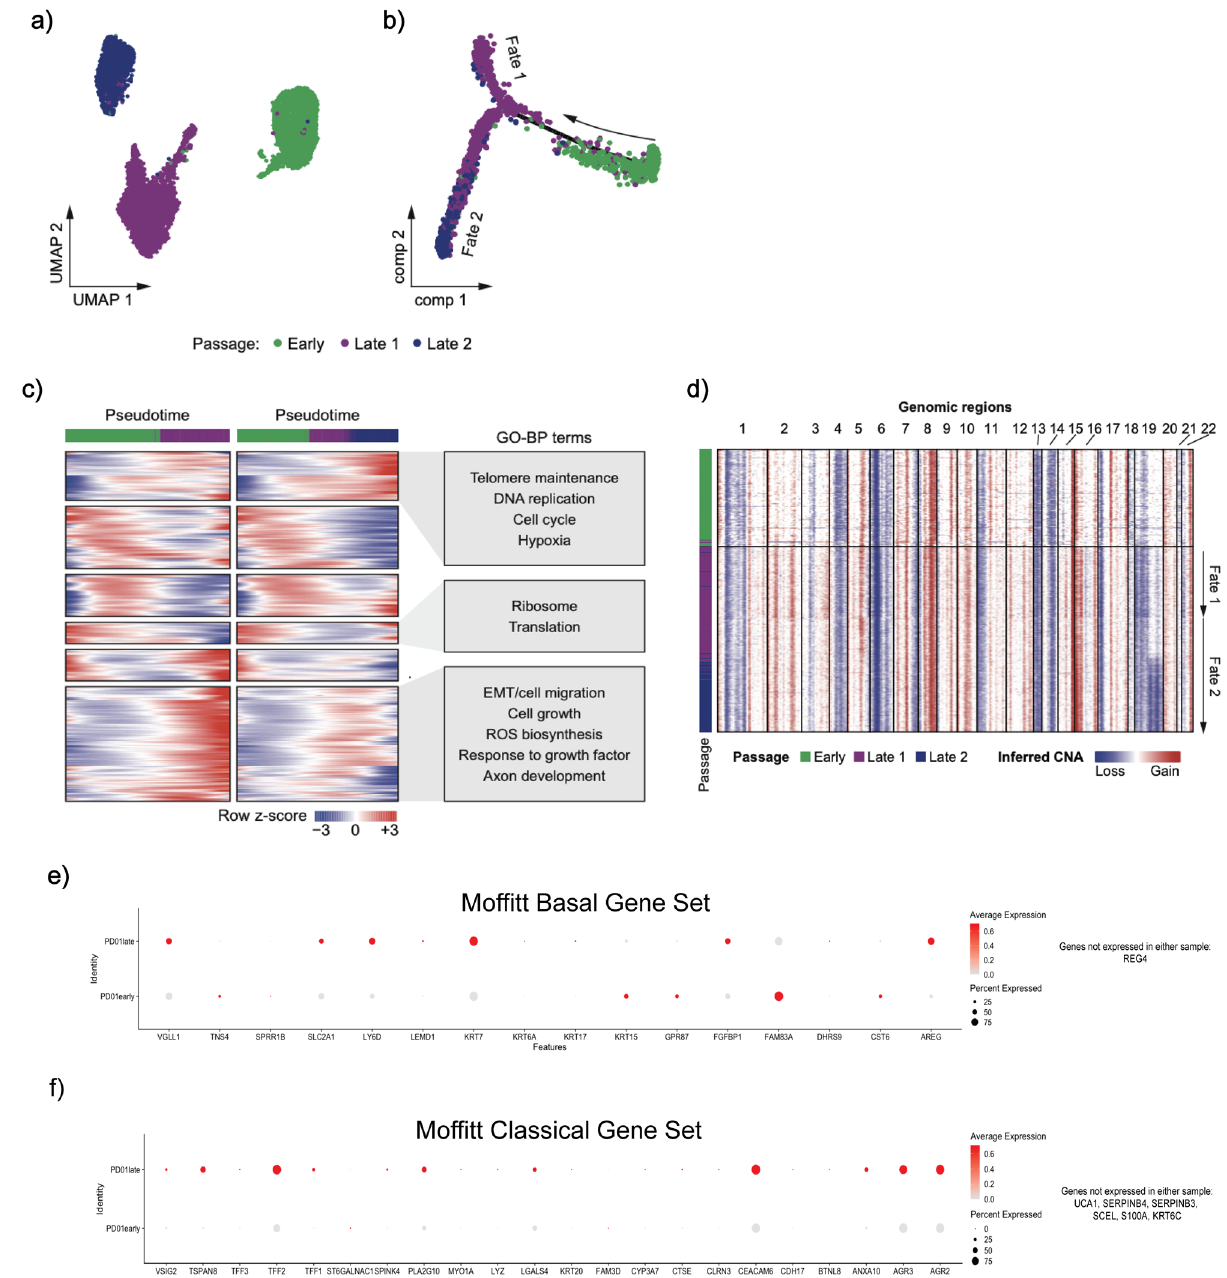
b Pseudotime analysis performed using Monocle of single cells from early (green) and late (purple, navy) passage organoids. c Branched heatmap (left) showing dynamic gene expression along the pseudotime trajectory for each cell fate in b . Pseudotime progresses from left to right. Enriched Gene Ontology biological process terms for each gene cluster are listed on the right. d Heatmap showing inferred copy number alterations of early and late passage organoids. Cells (rows) are ordered by pseudotime. Red represents copy number gains and blue represents copy number losses. e Comparison of expression of Mof fi tt Basal subtype genes in scRNA of early (bottom) vs. late (top) PDO1. f Comparison of expression of Mof fi tt Classical subtype genes in scRNA of early (bottom) vs. late (top)